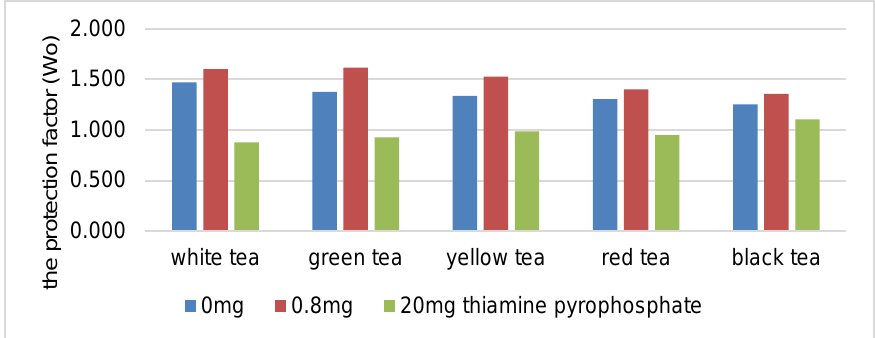
Figure 2. The protection factor (Wo) of ethanol tea extracts in the presence of thiamine pyrophosphate.